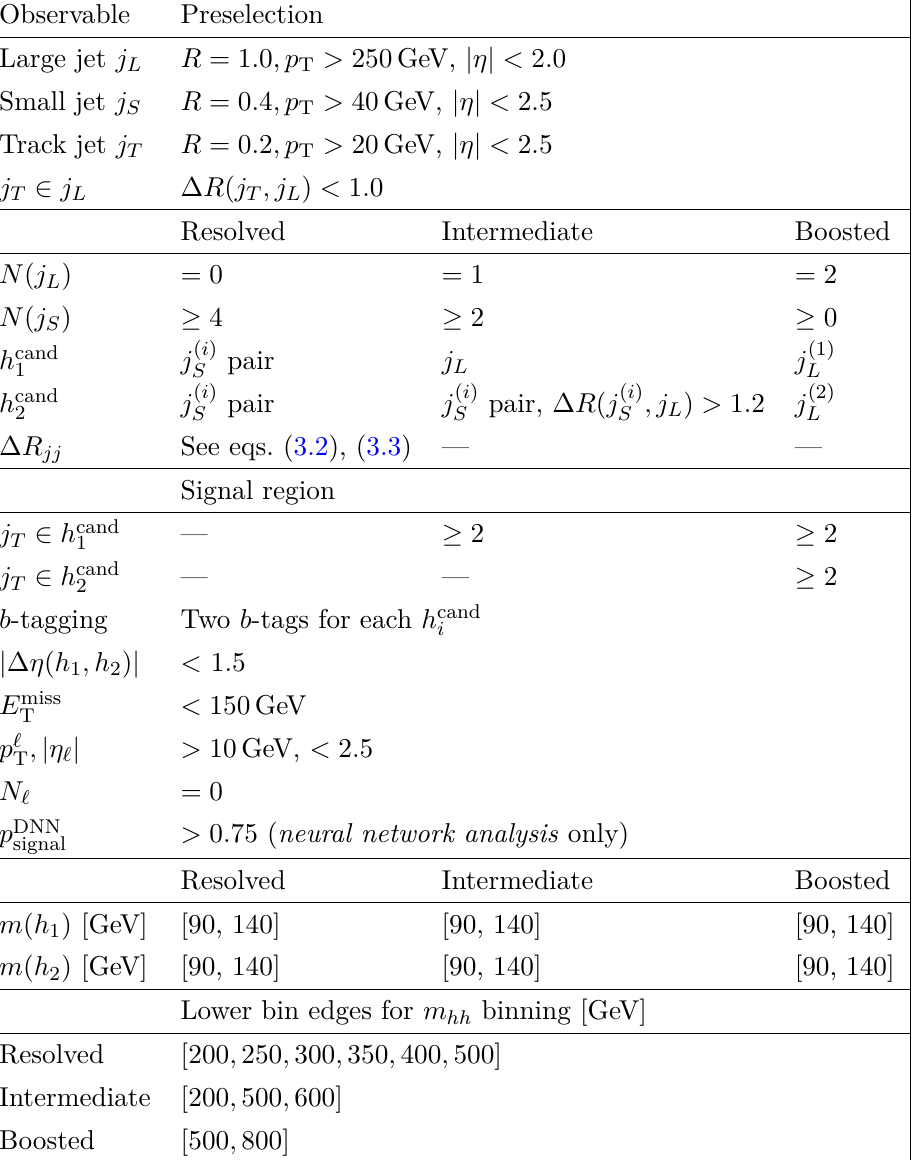
Table 2. Overview of event selection for the baseline analysis in the resolved, intermediate and boosted categories. The requirements above the ‘Signal region’ heading are the same as the pres- election used for the neural network analysis training. The requirements below the ‘Signal region’ heading are the signal region requirements. The lower bin edges for the m hh binning scheme is shown in the bottom three rows. See the main text for